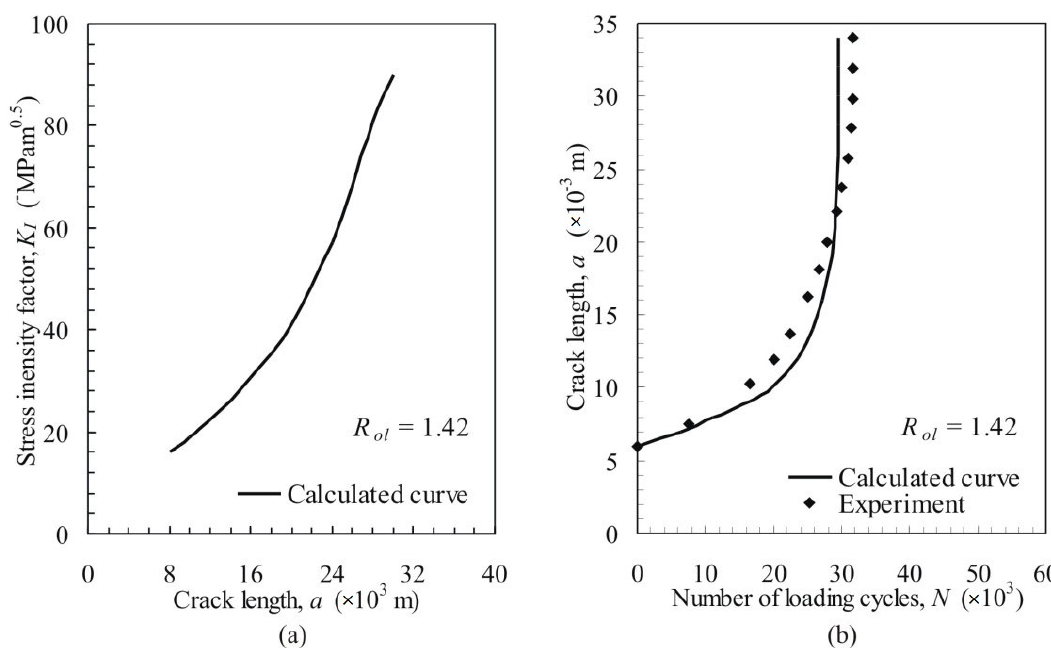
Figure 2. Fatigue resistance analysis: ( a ) K I versus a , R ol = 1.42 and ( b ) a versus N , R ol = 1.42, calculated curves from the present work, experiments reported by Kumar [32].